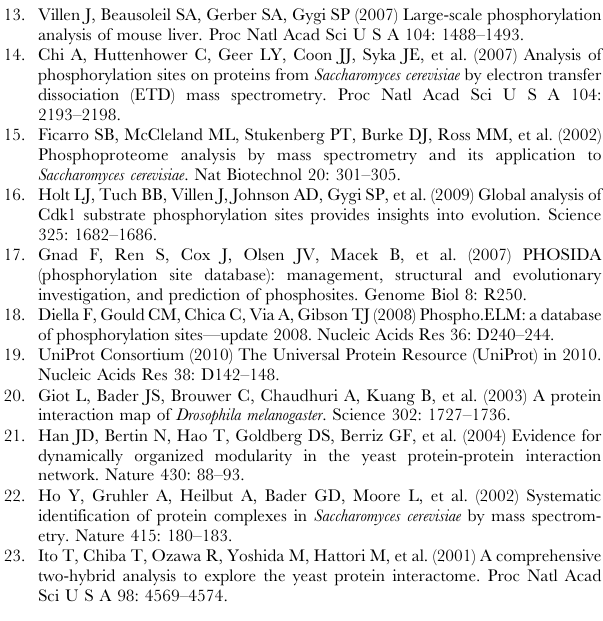
the false-positive rate or ‘‘1 – specificity’’ (defined here as the fraction of nonphosphoproteins incorrectly predicted to be phosphoproteins) are shown at a series of score thresholds. Figure S4 Differences between node degree levels of phospho- proteins and nonphosphoproteins at each level of protein size. See legend to Fig. 4 for details. Analyses were performed for the phospho-PPI networks of ‘‘ALL’’ (A–C) and ‘‘Y2H’’ (E–F). Each bin corresponds to the protein length between AA and AA + 100 (amino acids). See legend to Fig. 4 for details. Figure S5 Comparison of node degree counts of phosphopro- teins and nonphosphoproteins in terms of yeast functional annotations. The type of phospho-PPI network is ‘‘ALL.’’ For proteins corresponding to each Gene Ontology annotation of ‘‘biological process’’ (A), ‘‘molecular function’’ (B) and ‘‘cellular component’’ (C) in the S. cerevisiae GO Slim set, the average node degree of phosphoproteins divided by that of nonphosphoproteins is represented as the P to N (P/N) ratio. Figure S6 Number counts of intersections between pair-wise protein relationships in the literature-derived signaling collection and in the PPI. For each category of PPI data, the number count of signaling reactions matched to protein interactions is repre- sented by an arrow, along with P values estimated from negative controls generated by 10,000 repeats by RER. Gray bars represent the probability density distribution of the number count of the intersection observed using the negative controls generated by RER. Figure S7 Cumulative probability distributions of node degrees of nonphosphoproteins, phosphoproteins with a single phospho- site, and phosphoproteins with two or more phosphosites in the phospho-PPI data of the ‘‘ALL’’ category. For each dataset, bars